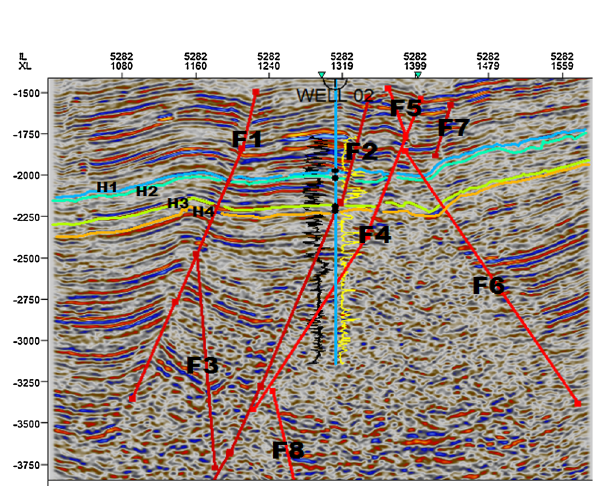
Fig. 10 Seismic structural analysis at inline 5282